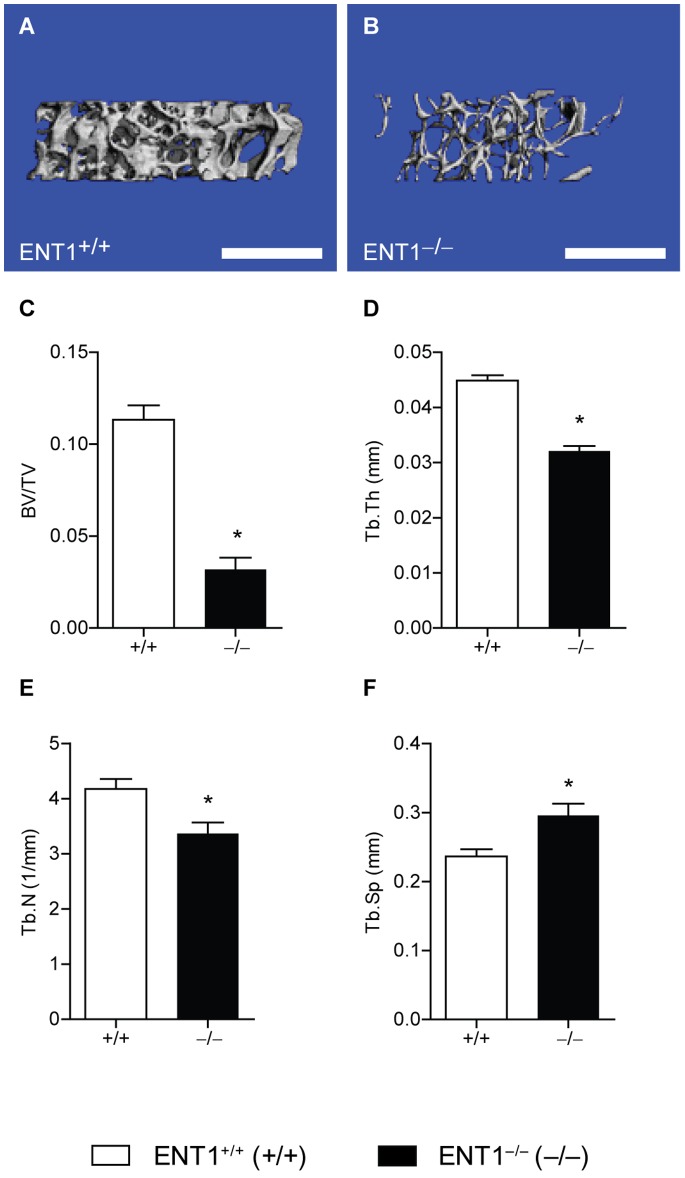
ENT1 null mice have reduced trabecular bone volume fraction, thickness and number and increased trabecular separation in the femur by micro computerized tomography (microCT).Representative cross section through the trabecular bone of the distal femoral metaphysis of the femur of (A) wild-type and (B) ENT1 null mice. Scale bar = 1 mm. C Reduced trabecular bone volume fraction (BV/TV), which is equal to the percentage of the tissue space that is occupied by bone within the lumbar vertebral body, of ENT1 null mice compared to wild-type mice. D Trabecular thickness (Tb.Th) or the average thickness of the trabecular struts was reduced in ENT1 null mice compared to wild-type littermates. E Trabecular number (Tb.N) or a measure of the number of trabeculae within a given space was decreased in ENT1 null mice relative to wild-type mice. F Trabecular separation (Tb.S) or the average spacing between adjacent trabeculae was reduced in ENT1 null compared to wild-type mice. n = 3 per genotype. *P<0.05 by Student’s two-tailed t test. All data are presented as mean ± SEM.